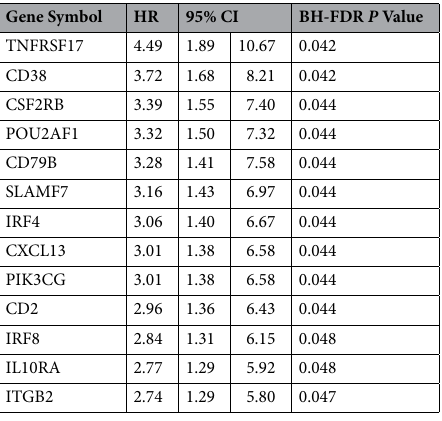
Table 3. Univariate Cox regression analysis of differentially expressed genes between with high- versus low- invasive front for predicting EFS in muscle invasive urothelial carcinomas treated by cystectomy. HR Hazard Ratio, CI Confidence Interval, BH-FDR Benjamini–Hochberg procedure to decreases the false discovery